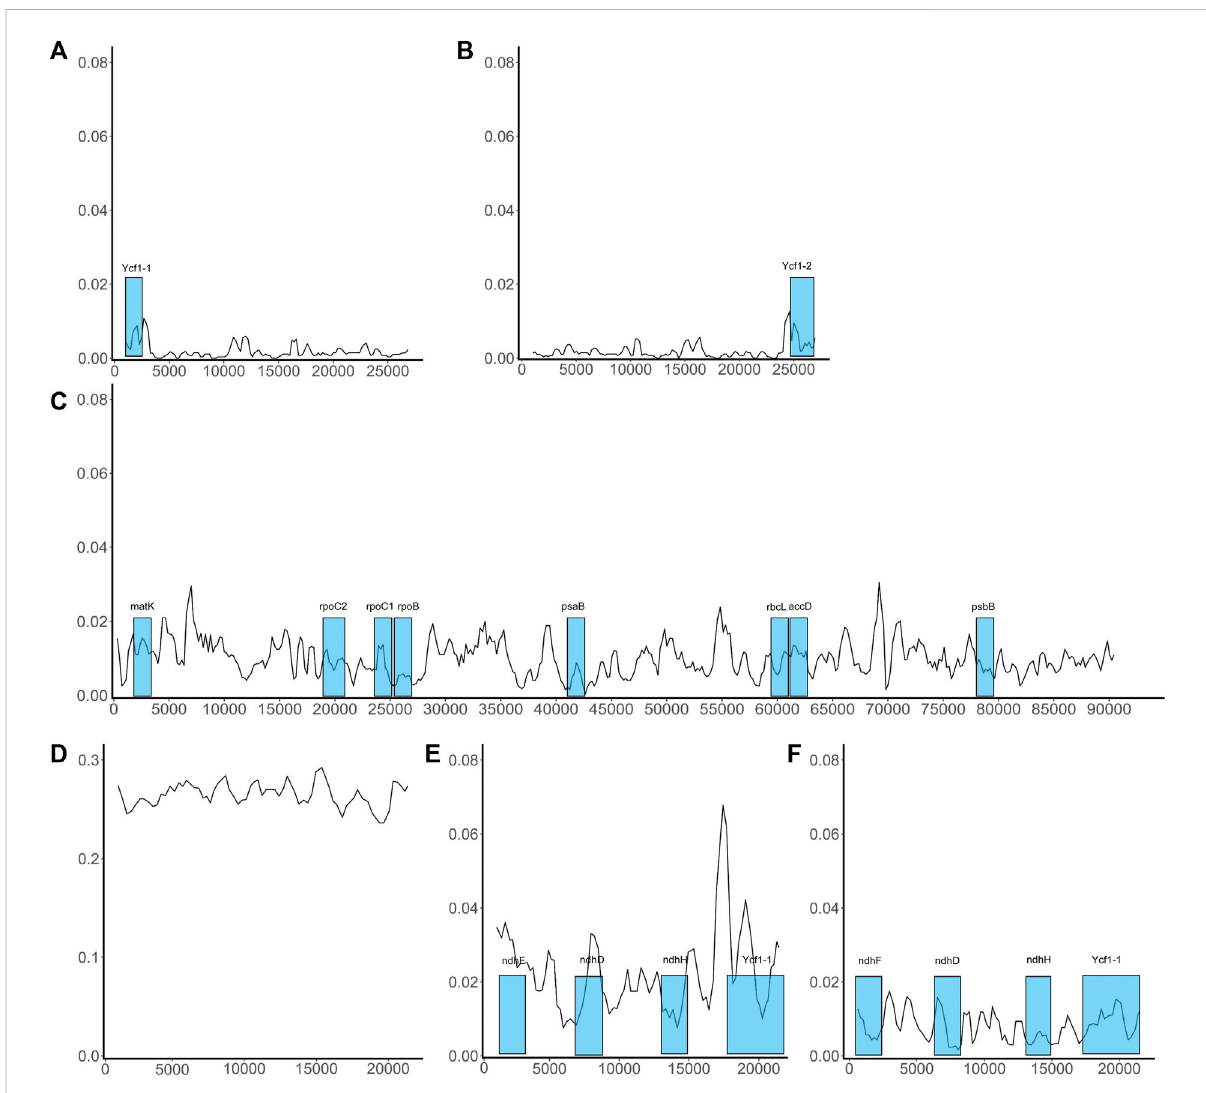
FIGURE 6 Sliding window analysis of the whole chloroplast genome of Piper species. X -axis shows the position; Y -axis, nucleotide diversity of each window.Thecodinggenesthatcanbeusedasbarcodeswerescreenedoutandtheirlocationsarehighlightedinblueboxes. (A) ThedistributionofPi valuesinIRaregion; (B) ThedistributionofPivaluesinIRbregion; (C) ThedistributionofPivaluesinLSCregion; (D) ThedistributionofPivaluesinSSC region; (E) ThedistributionofPivaluesinSSCregionofthespeciessetwith5species; (F) ThedistributionofPivaluesinSSCregionofthespecies set with 4